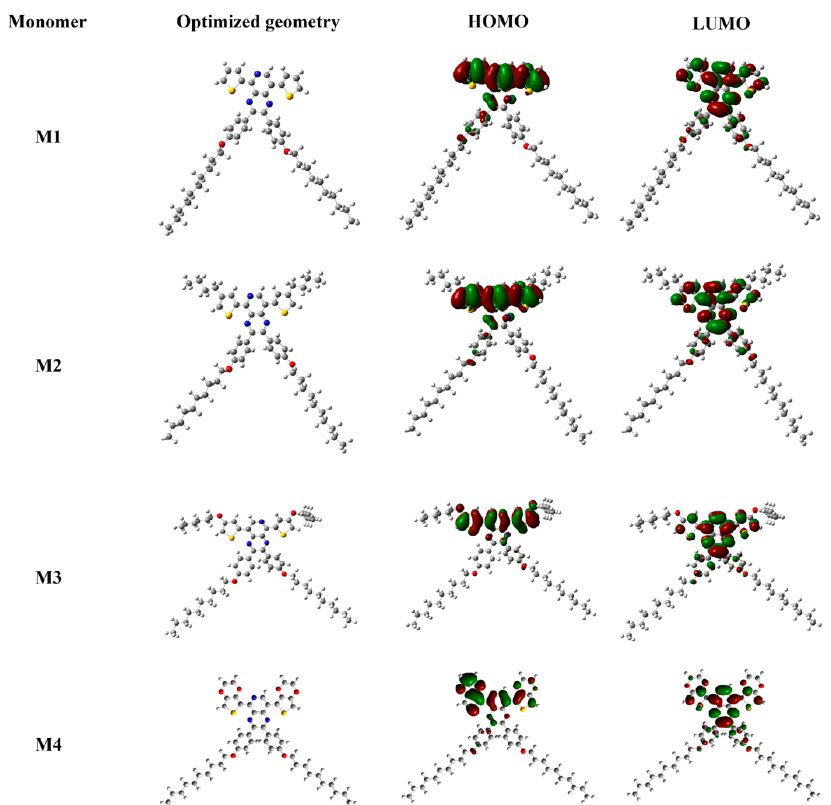
Figure 7. Optimized geometries and molecular orbital surfaces of the HOMOs and LUMOs for M1, M2, M3 and M4, the different colors suggested the different electronic cloud densities.